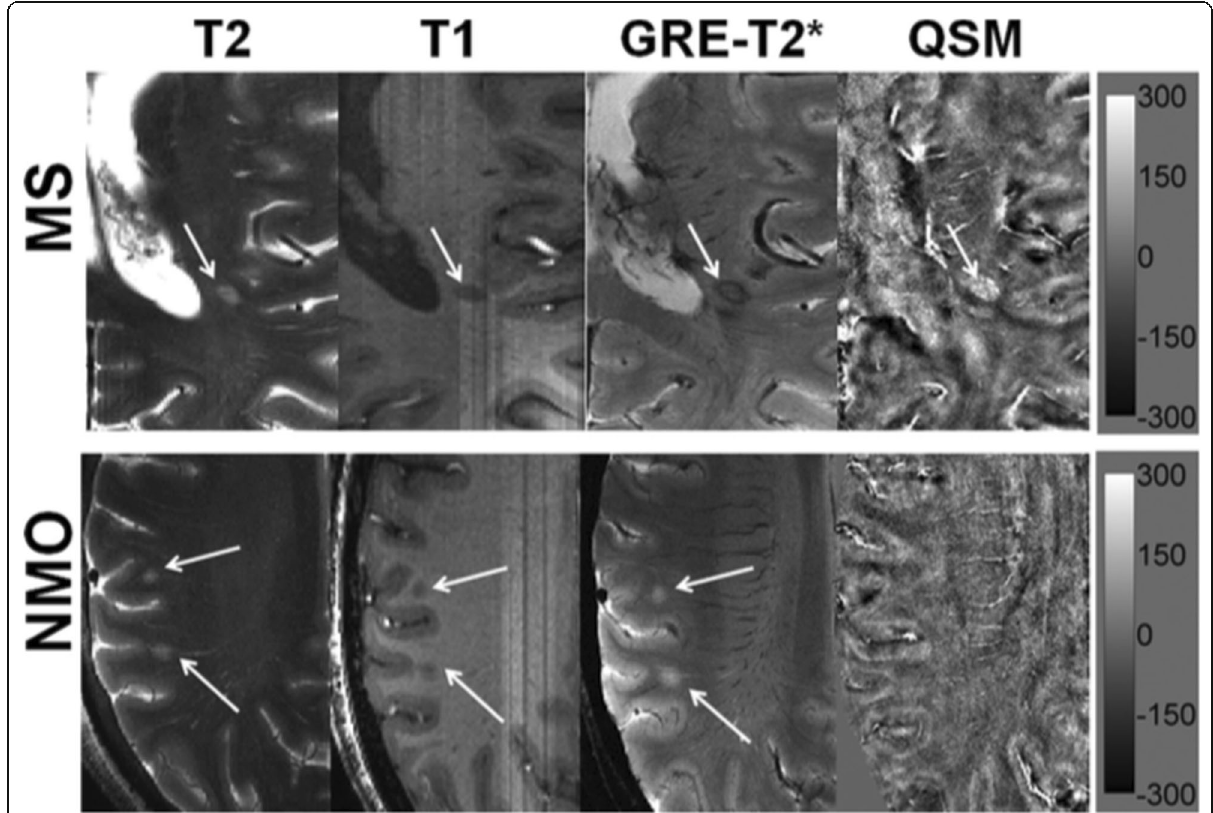
Fig. 5 Distinguishing multiple sclerosis (MS) from neuromyelitis optica (NMO) lesions. In the upper row, a patient with multiple sclerosis, from left to right: axial T2-weighted image (T2) with a hyperintense lesion (white arrow) traversed by an ill-defined central venule; the same lesion appears hypointense on a T1-weighted magnetisation-prepared rapid gradient echo image (T1), with hypointense peripheral rim and iso-to-hypointense central core traversed by a well-defined venule on a gradient-echo T2*-weighted image (GRE-T2*), and hyperintense on quantitative susceptibility mapping (QSM). Hypointense signal intensity within the lesion on T2*-weighted image and hyperintensity on QSM suggest iron accumulation. In the lower row, a patient with NMO, from left to right: axial T2-weighted image with two round hyperintense lesions (white arrows); the same lesions appear hypointense on T1, hyperintense on GRE-T2*, and isointense on QSM, thus inconspicuous with iron accumulation. The scale bar is for the QSM image with units of parts per billion. Published with permission from AJNR Am J Neuroradiol